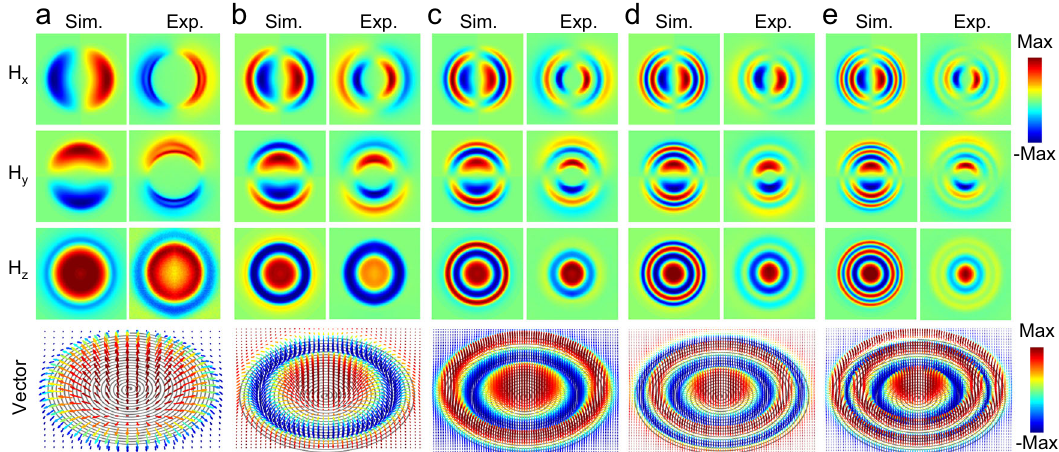
Fig. 4 Real-space imaging of the vectorial magnetic skyrmion con fi gurations. a – e Upper panels: Simulated and measured 3D vectorial components of magnetic fi eld ( H x , H y , H z ) patterns; Bottom panel: unit vector fi eld con fi gurations of the EM skyrmion modes, of mode index ( a ) m = 1, ( b ) m = 2, ( c ) m = 3, ( d ) m = 4, and ( e ) m = 5, respectively. Max in the color bar represents the maximum amplitude of the fi eld